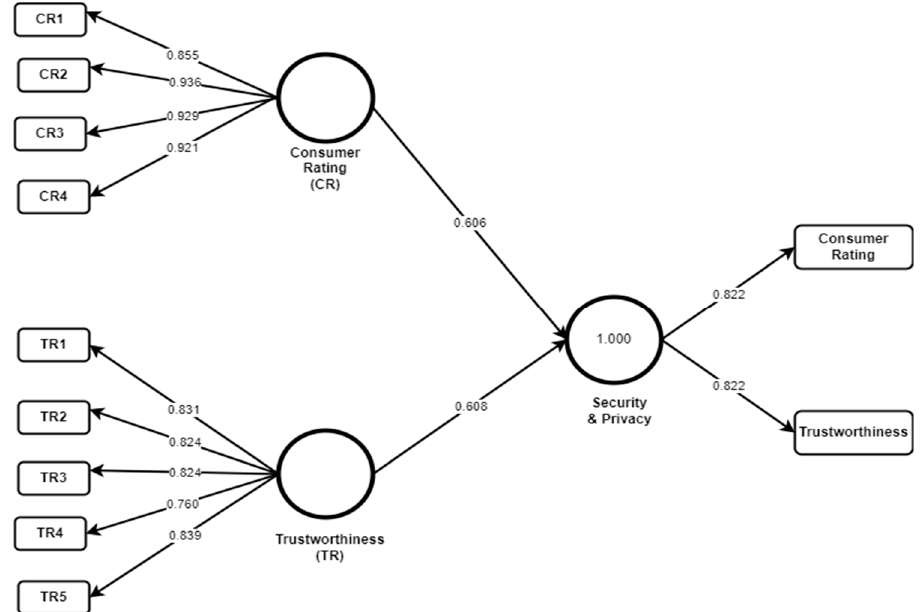
Figure 5. Namshi model.